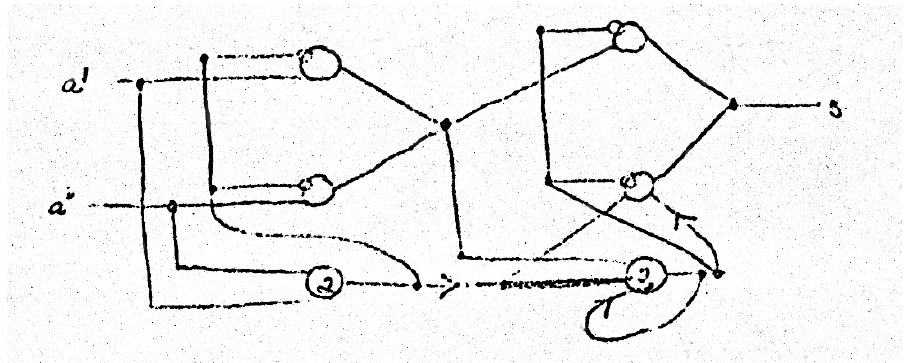
Figure 5. Goldstine drew this adder in what appears to be a draft version of a letter. Whether the letter was actually sent to von Neumann is uncertain. Courtesy of the American Philosophical Soci- ety.